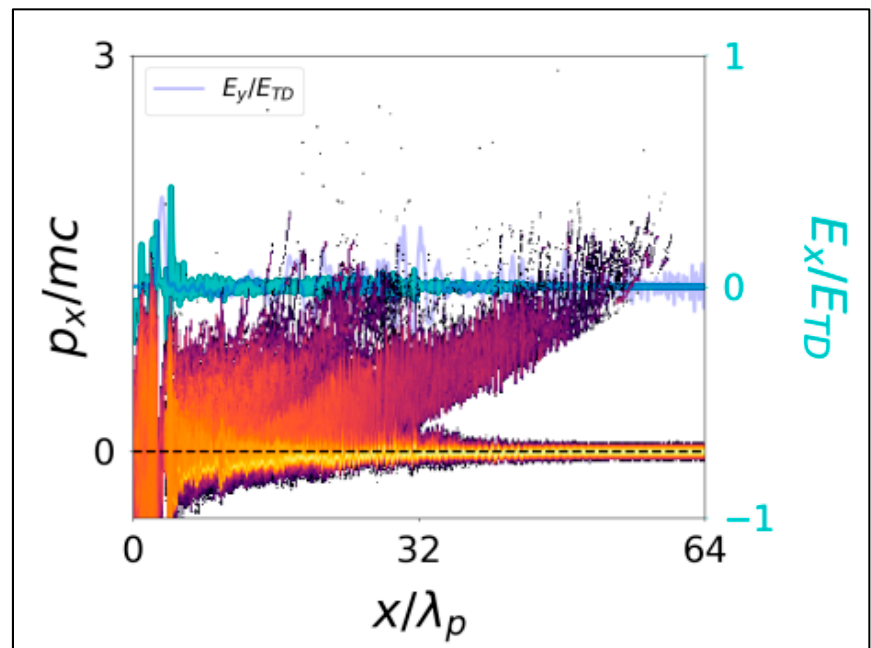
Figure 1. Electron phase space and field structure for a critical density case n c /n e = 1 and a laser pulse of length 8 λ p at a laser intensity a 0 = 1. Data shows the buildup of a large population of low-energy accelerated electrons for a high-density plasma (from Nicks et al. [18]).